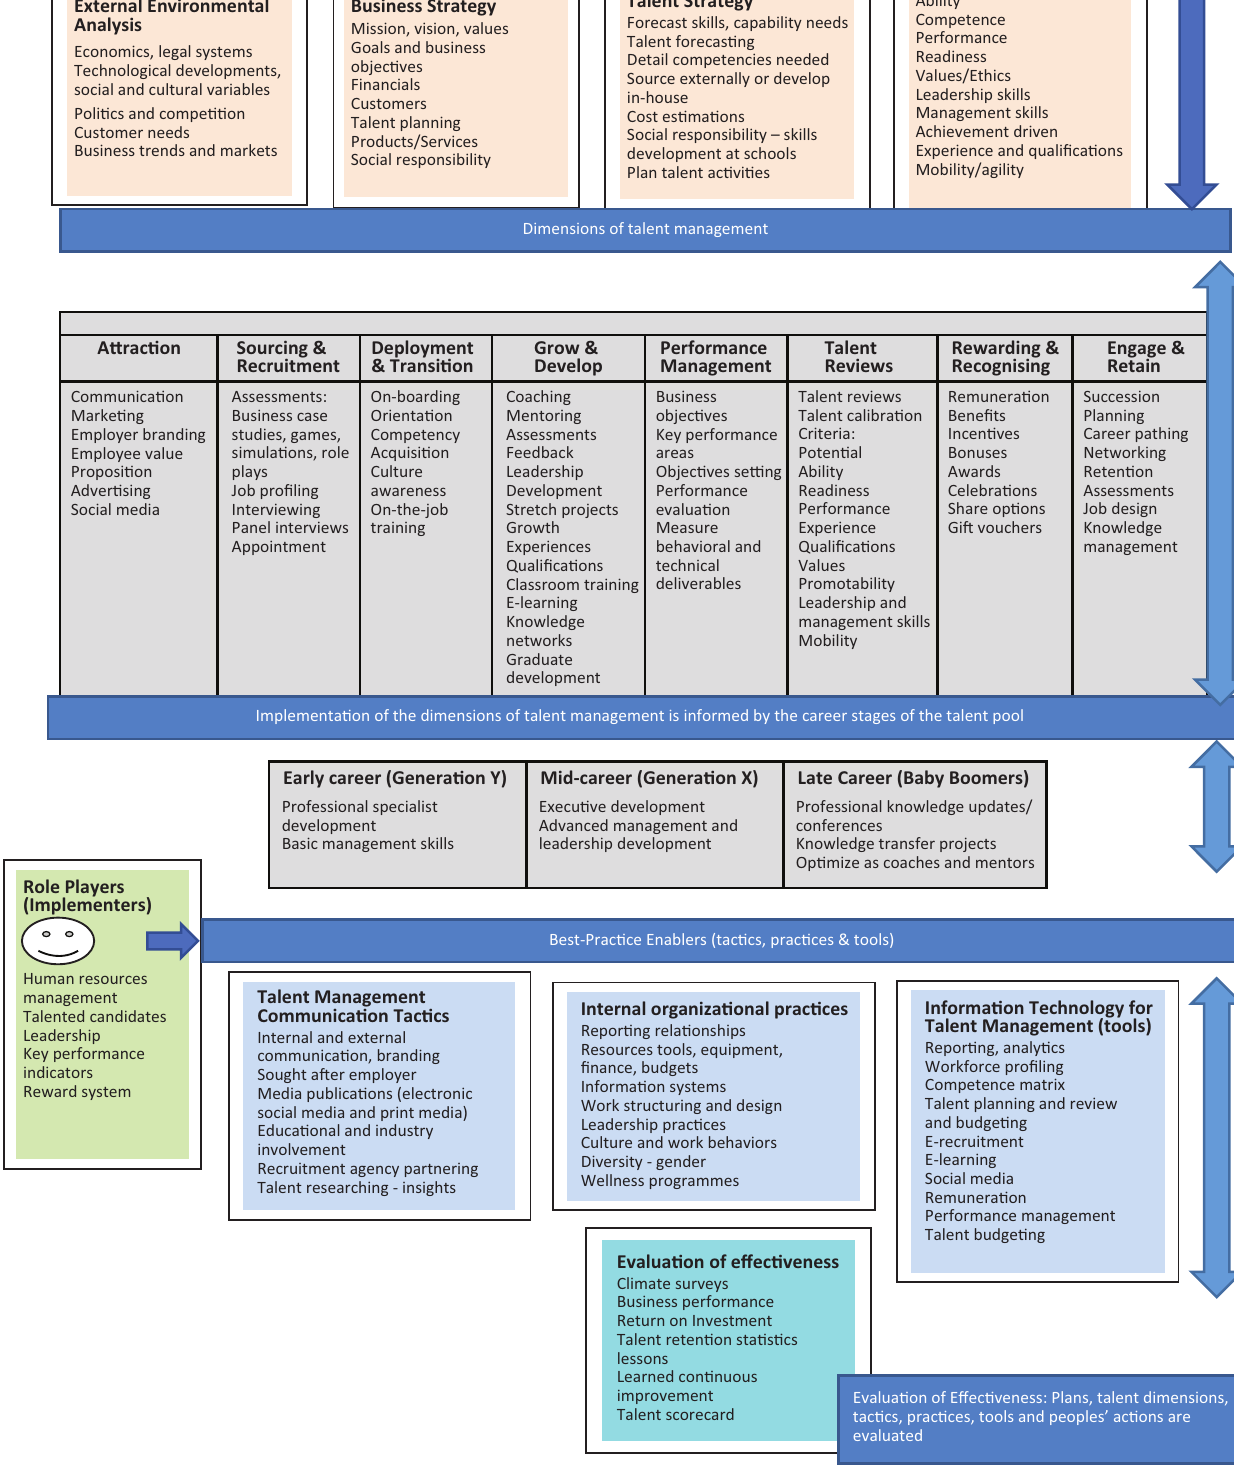
FIGURE 1: A talent management framework for the private